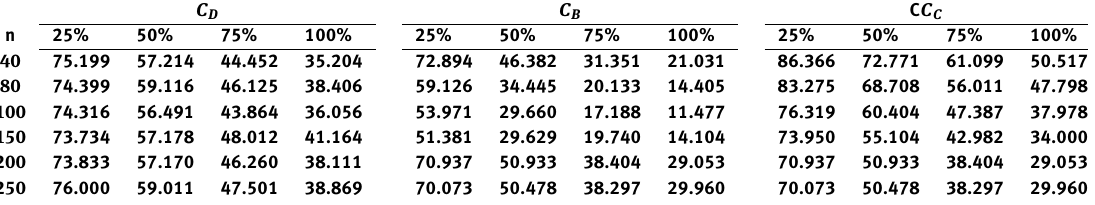
Fig. 5. Relative Degree network centrality